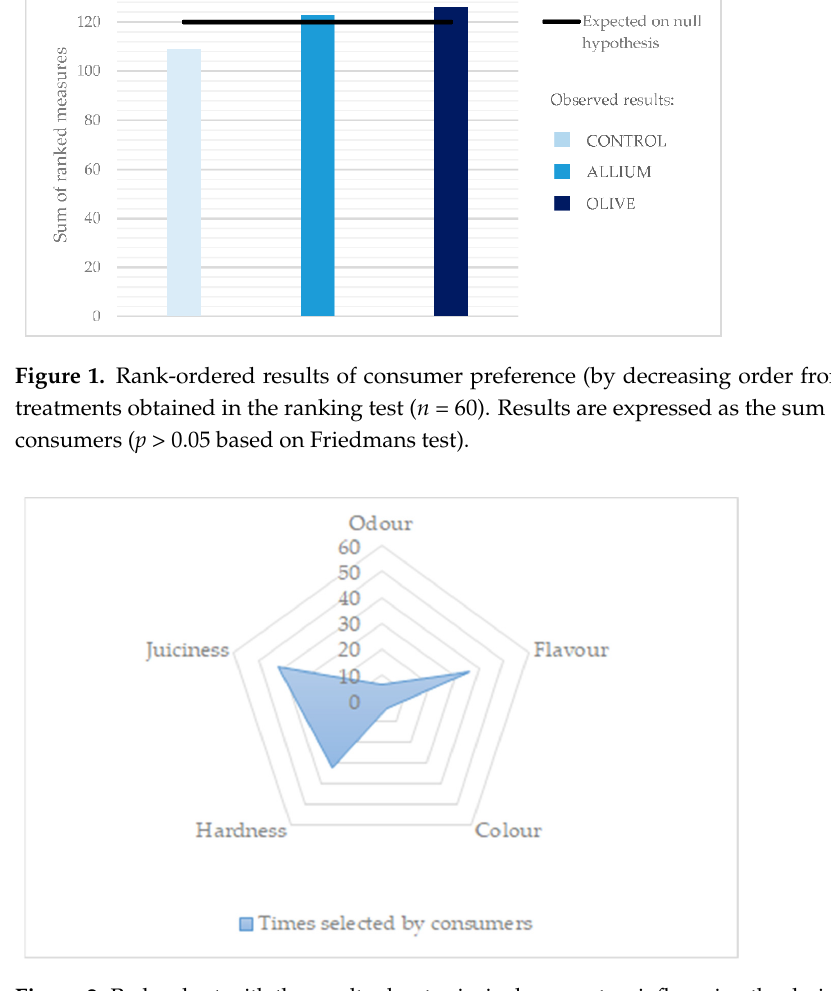
Figure 2. Radar chart with the results about principal parameters influencing the decision of con- sumers (n = 60) on the ranking test. Results are expressed as the sum of consumers selecting each